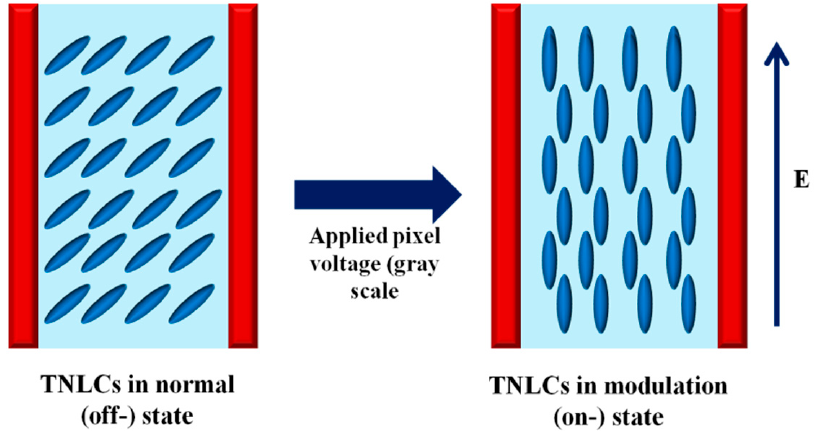
Figure 1. Schematic of the relative rotation of TNLCs with respect to applied pixel voltage (grayscale) of the SLM (TNLC: twisted nematic liquid crystal, E: direction of the applied electric field). When pixel voltage (grayscale) is applied to the SLM, it provides an additional phase to the y -polarized light, whereas the x -component of light remains